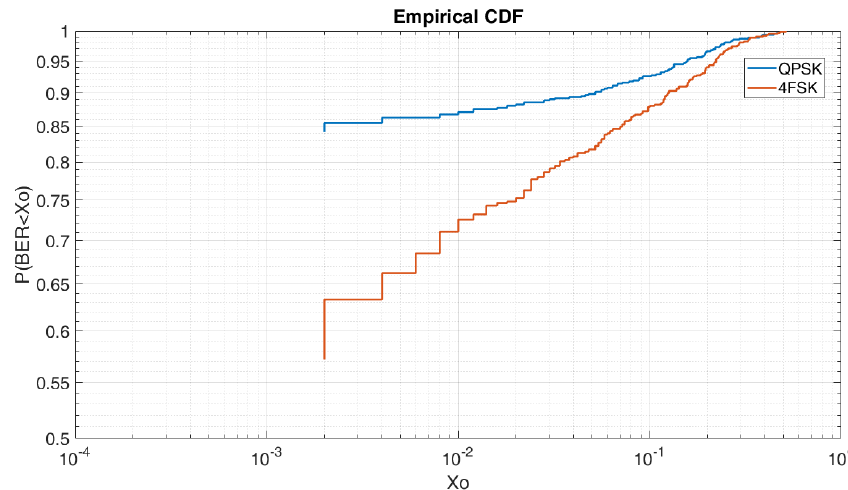
Figure 14. NVIS CDF NVIS QPSK and 4FSK.